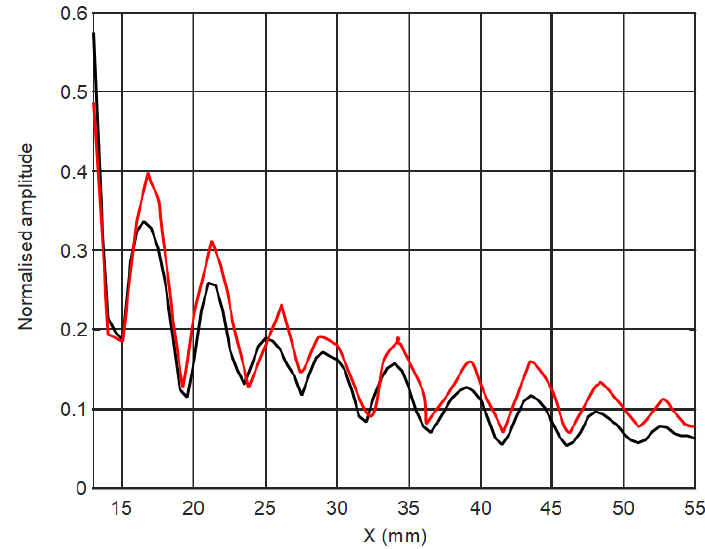
Figure 18. The spatial distribution of the normalized displacement amplitudes in the plastic film excited by the eight-element air-coupled array: black color—measured, red—calculated.